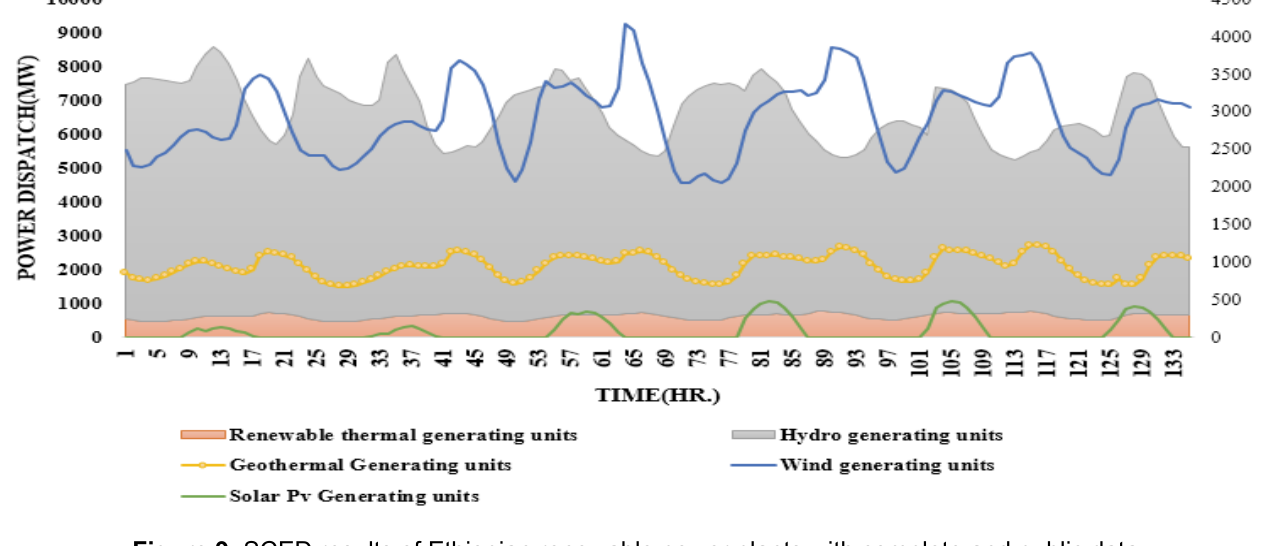
Figure 9. SCED results of Ethiopian renewable power plants with complete and public data